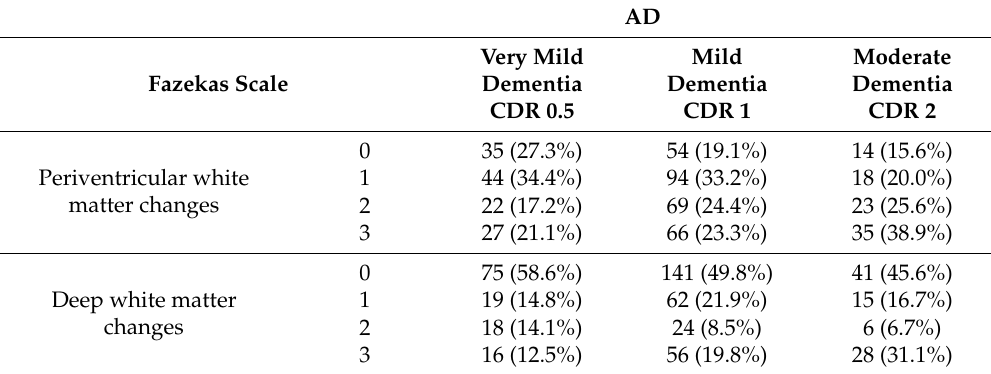
136 Table 2. Relationship between white matter changes and the severity of Alzheimer’s disease.